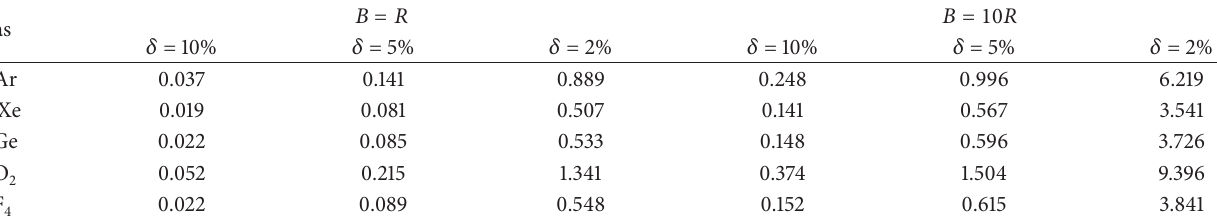
Table 1: The times of measurements in years at reactor on and reactor off to get a relative uncertainty 𝛿 at 𝐵 = 𝑅 and 𝐵 = 10𝑅 .